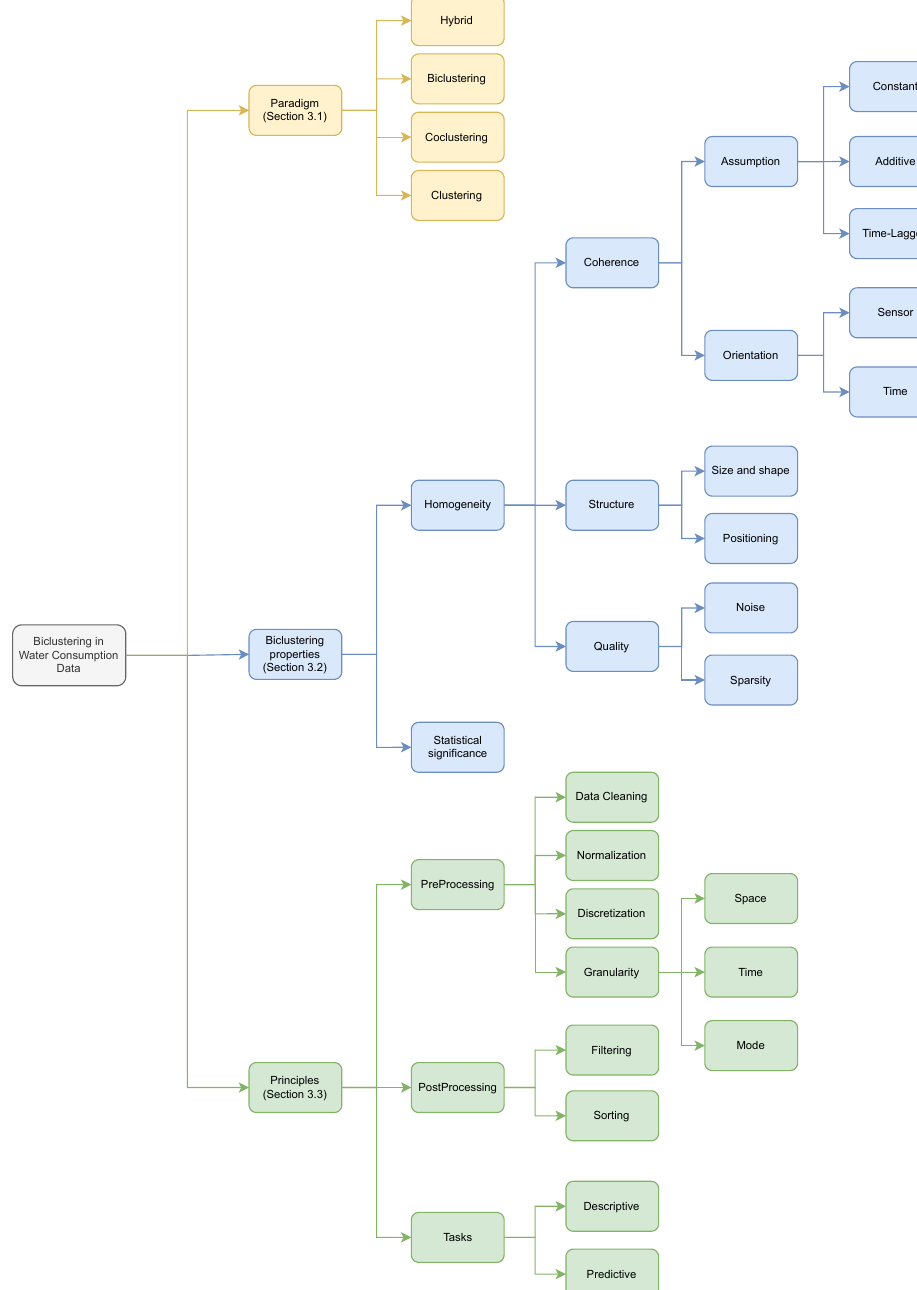
Figure 4. Taxonomy of Biclustering-based data analysis on water demand data: structured view on the major biclustering paradigms, biclustering aspects affecting the analysis, and principles to design and assess biclustering-based